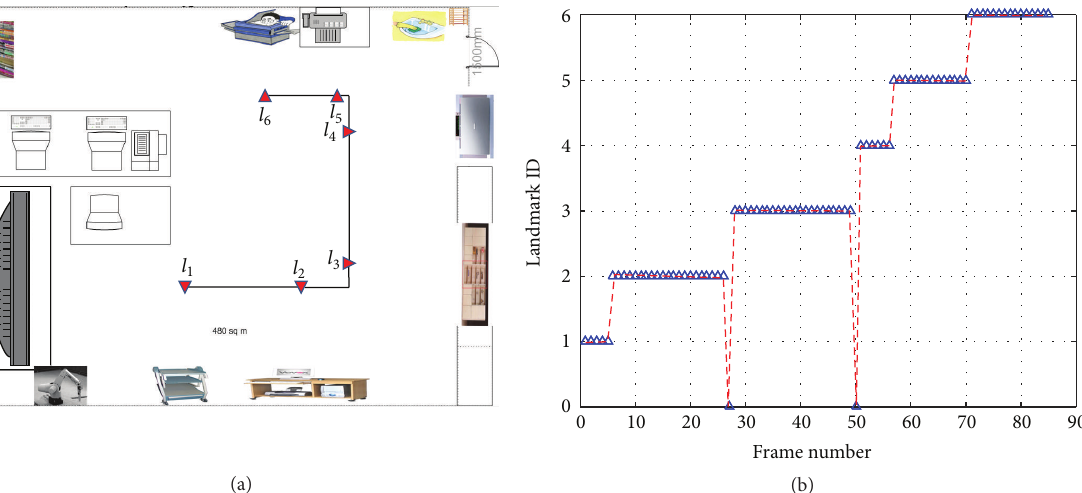
Figure 16: Object recognition-based topological localization: (a) topological map with labels, (b) topological recognition results. Zero label indicates missed